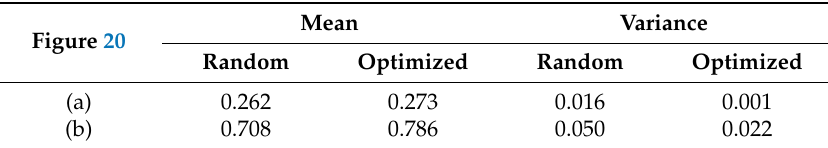
Table 15. Mean and variance of curves in Figure